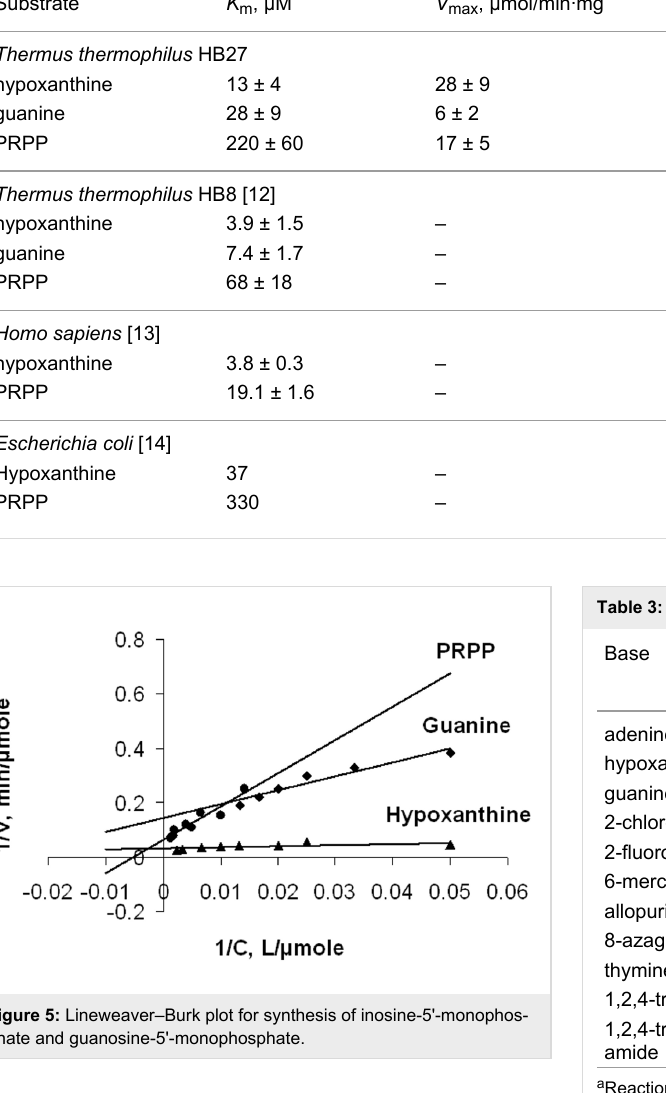
Table 2: Kinetic parameters of inosine-5'-monophosphate and guanosine-5'-monophosphate synthesis using HPRT from various organisms. Substrate